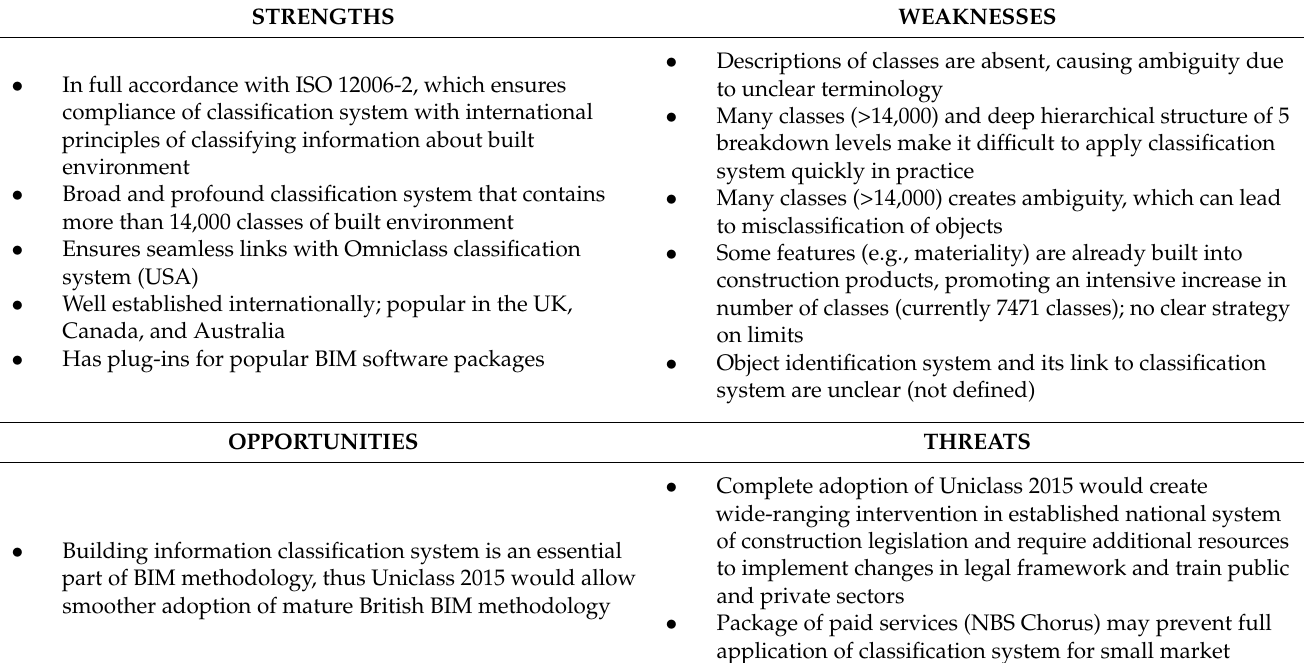
Table 13. SWOT analysis of Uniclass 2015 as NCICS